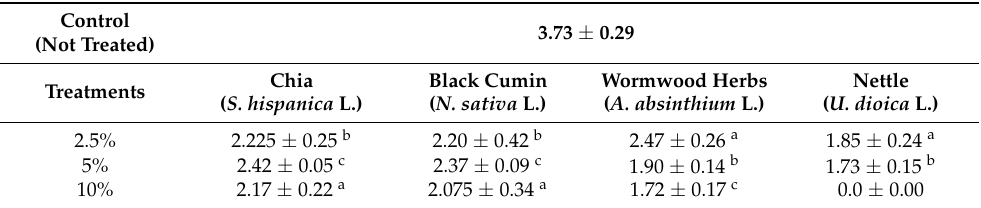
Table 8. Comparison of differences of means hypocotyl length of pepper ( C. annuum L.) seedlings (The values in the table represent the mean value of hypocotyl length in cm ± SD).